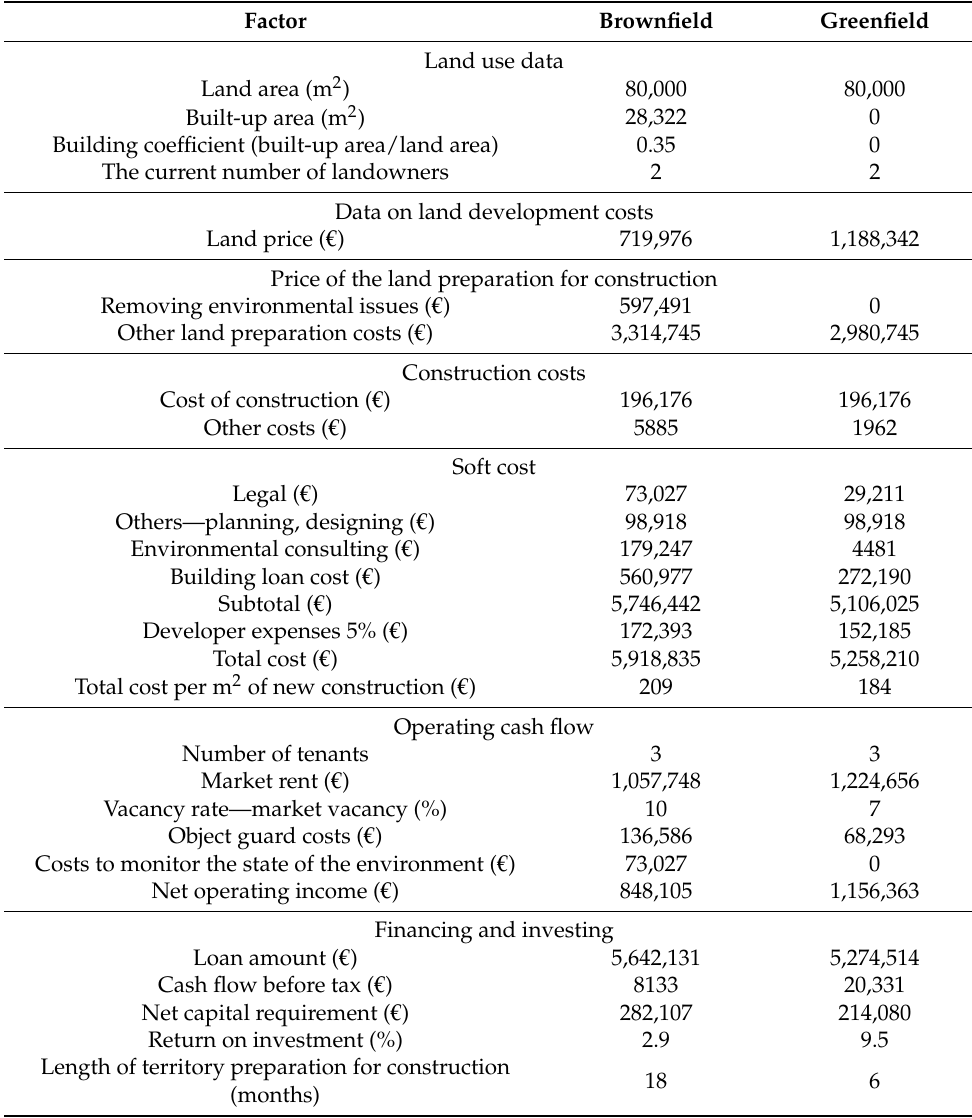
Table 5. The quantification of the investment costs of brownfield and greenfield industrial park implementation in the southwestern part of Eastern